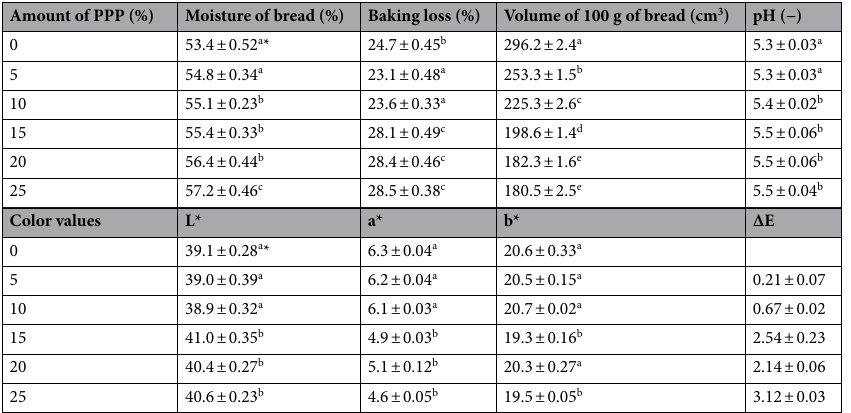
Table 1. Effect of different levels of pea protein powder (PPP) on the basic properties, and crumb color values of low-carbohydrate bread. *Values for the same parameters in the same kolumn marked with different letters are significantly (α = 0.05) different.